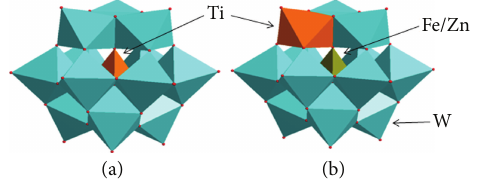
Figure 6: Keggin anion structure. (a) TiW 12 O 404− and (b) Fe ( Zn ) W 11 TiO 405−/6−